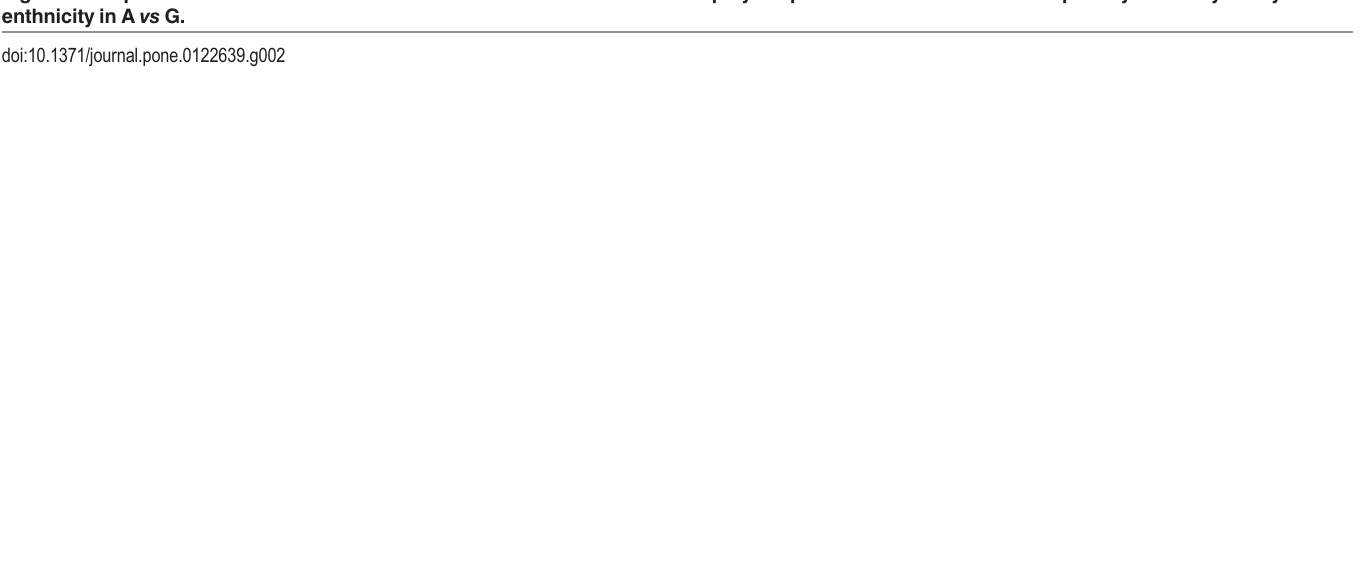
PLOS ONE | DOI:10.1371/journal.pone.0122639 April 7,